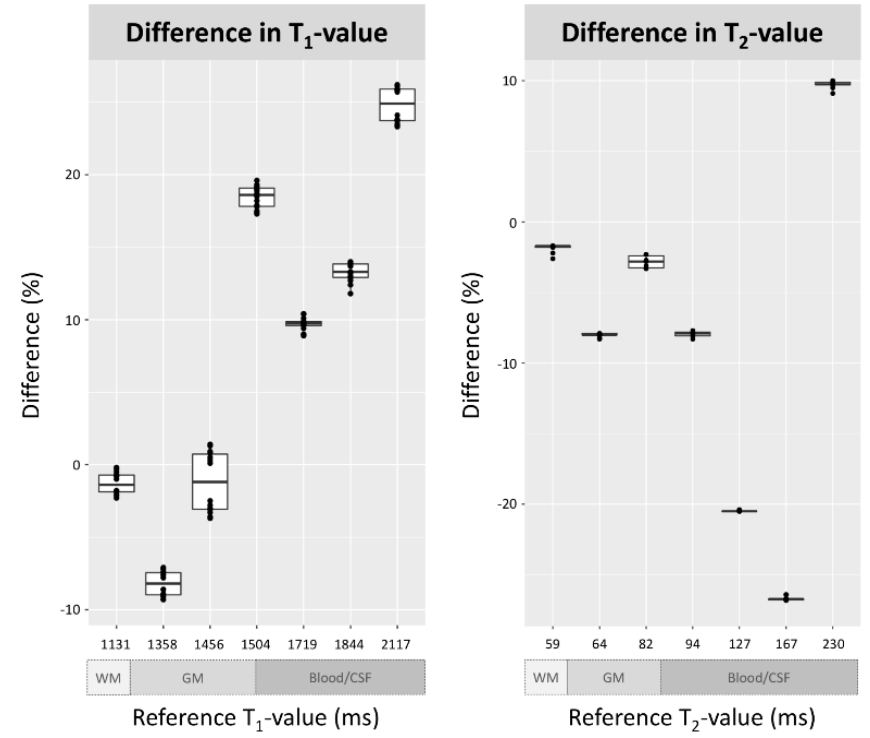
Figure 3. The difference in T 1 - and T 2 -values of two aqueous CuSO 4 phantoms between the synthetic and clinical scans.